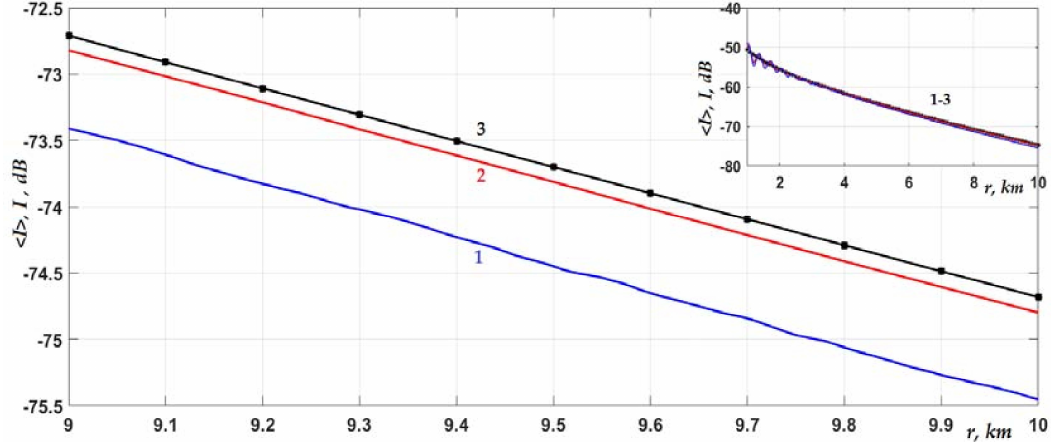
Figure 5. Attenuation of (cid:104) I (cid:105) of a signal with f = 250 Hz in the range r = 9–10 km in a waveguide with bathymetry fluctuations. (cid:104) c 1 (cid:105) = 1500 m/s, δ c 1 = 0. z = z 0 = 24 m. Curves: 1 is OW solution for L h = 100 m; 2 is OW solution for L h = 1 km; 3 (markers) is I , averaged over the interference scale ( δ h = 0).